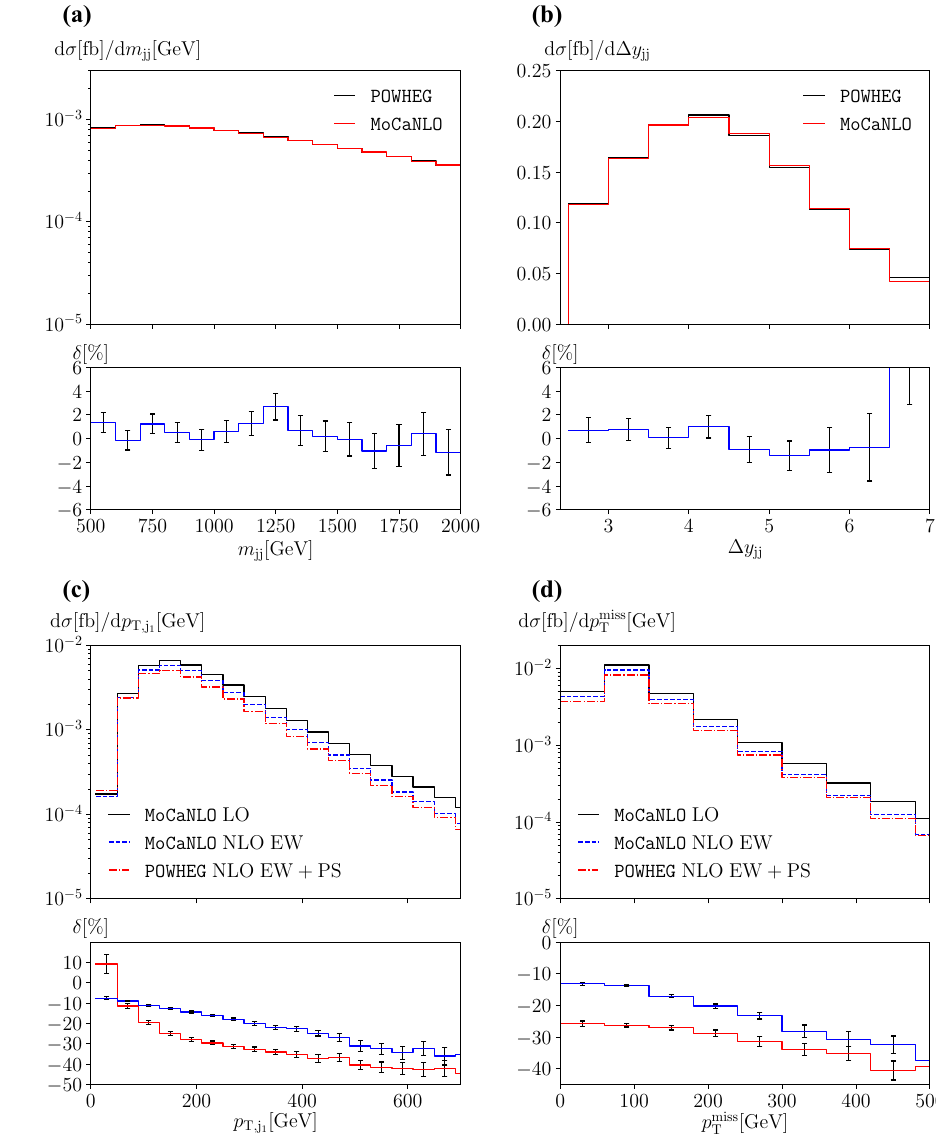
Fig. 4 Differential distributions (cid:2) (cid:3) α 6 at LO [order O ], NLO EW (cid:2) (cid:3) α 7 [order O ] and NLO EW+PS at a centre-of-mass √ s = 13TeV at the energy LHC for pp → μ + ν μ e + ν e jj: a invariant mass of the two leading jets (top left), b rapidity difference of the two leading jets (top right), c transverse momentum of the hardest jet (bottom left), and d missing transverse energy (bottom right). The upper panels show the LO prediction as well as the NLO predictions with and without PS. The lower panels show the relative NLO corrections with respect to the corresponding LO in per